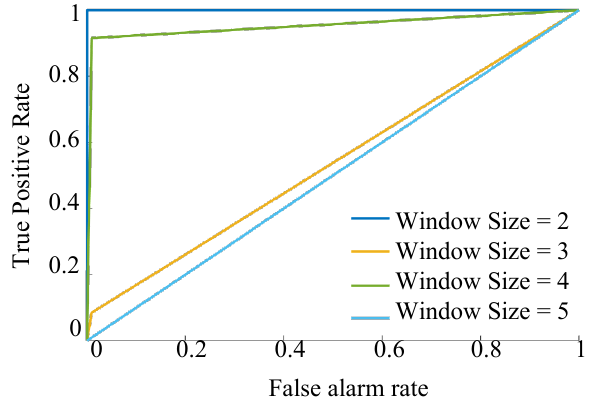
Figure 9. Receiver operating characteristic curve of PLV for different window